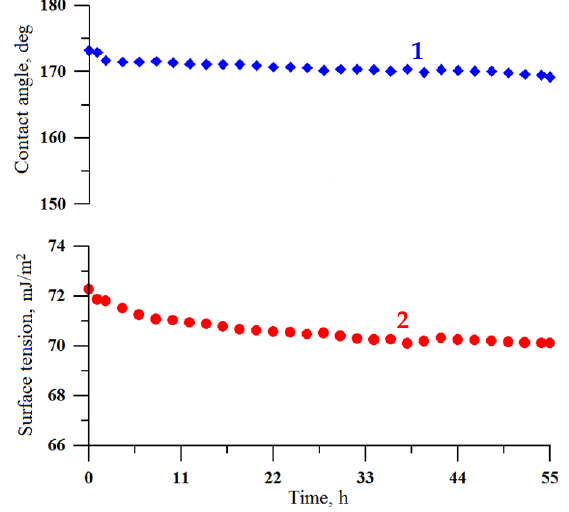
Figure 9. The variation of contact angle (1) and surface tension (2) of a water droplet at prolonged contact with the superhydrophobic coating on the tungsten surface obtained by regime 13.